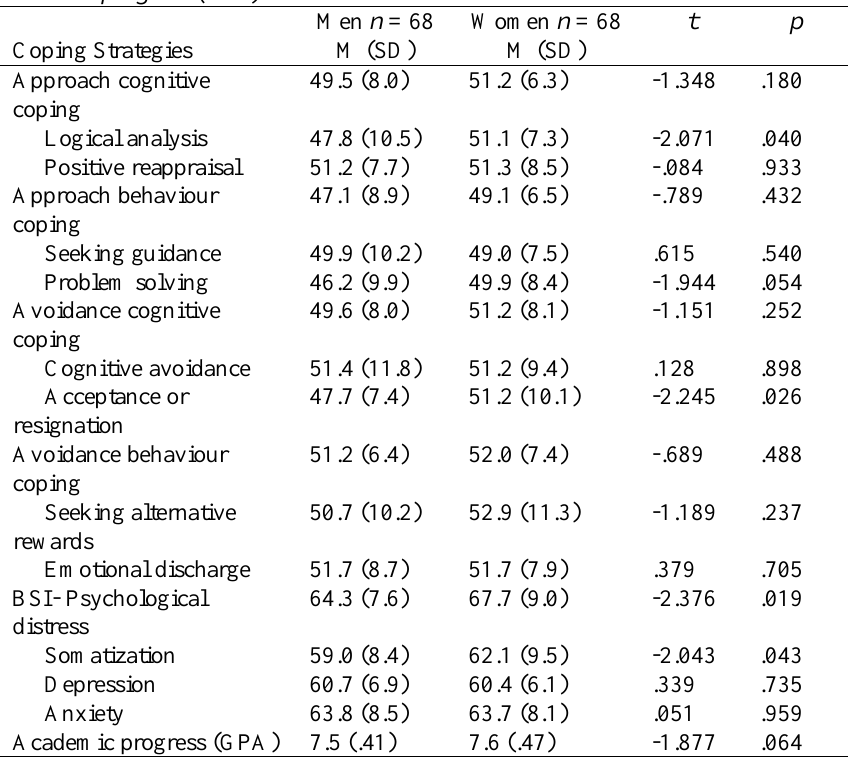
Mean differences by gender in coping (CRI-A), psychological symptoms (BSI) and academic progress